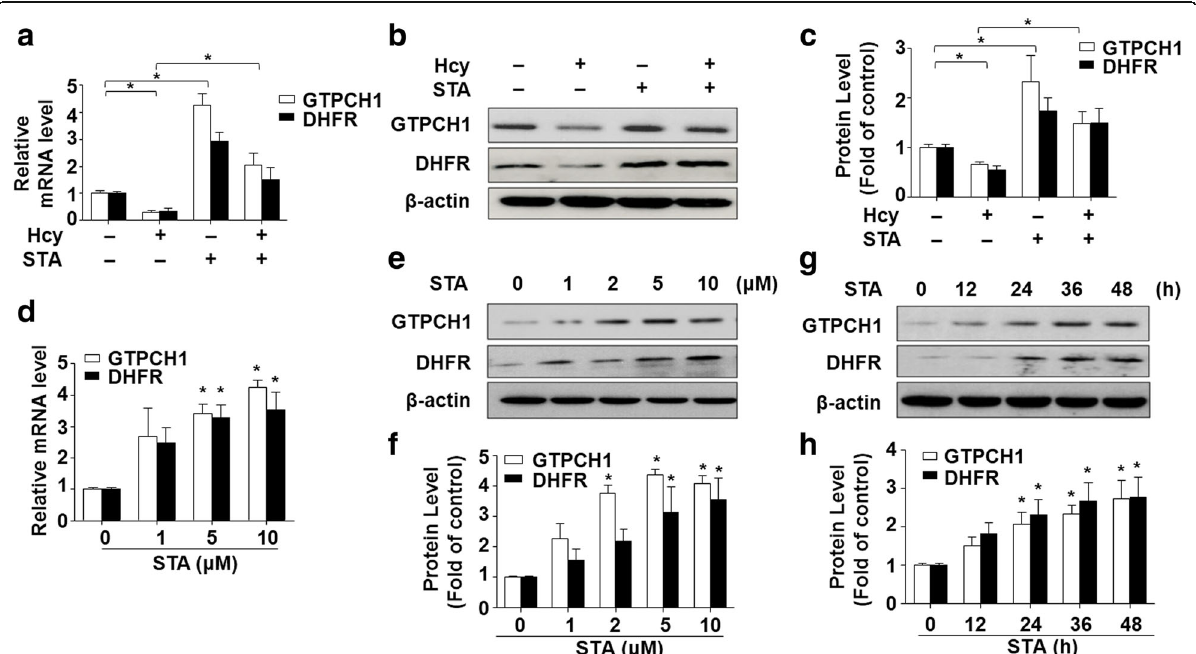
Fig. 5 STA increased the levels of GTPCH1 and DHFR. a Relative mRNA levels of GTPCH1 and DHFR were assessed by using qRT-PCR. b Protein levels were assessed by using Western blotting. c Quantification of GTPCH1 and DHFR protein levels, which was normalized to the β -actin levels. d The mRNA levels of GTPCH1 and DHFR were assessed by using qRT-PCR. e GTPCH1 and DHFR protein levels were assessed by using Western blotting. f Quantification of GTPCH1 and DHFR protein levels as in ( e ). g BAECs were incubated with 10 μ M STA for indicated time periods, GTPCH1 and DHFR protein levels were assessed by using Western blotting. h Quantification of GTPCH1 and DHFR protein levels as in ( g ). Data shown were mean ± SEM, n = 5. * P <